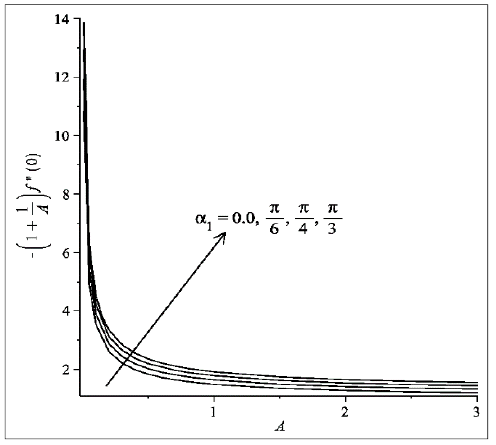
Figure 15. Various values of α 1 on the skin friction coe ffi cient and A .